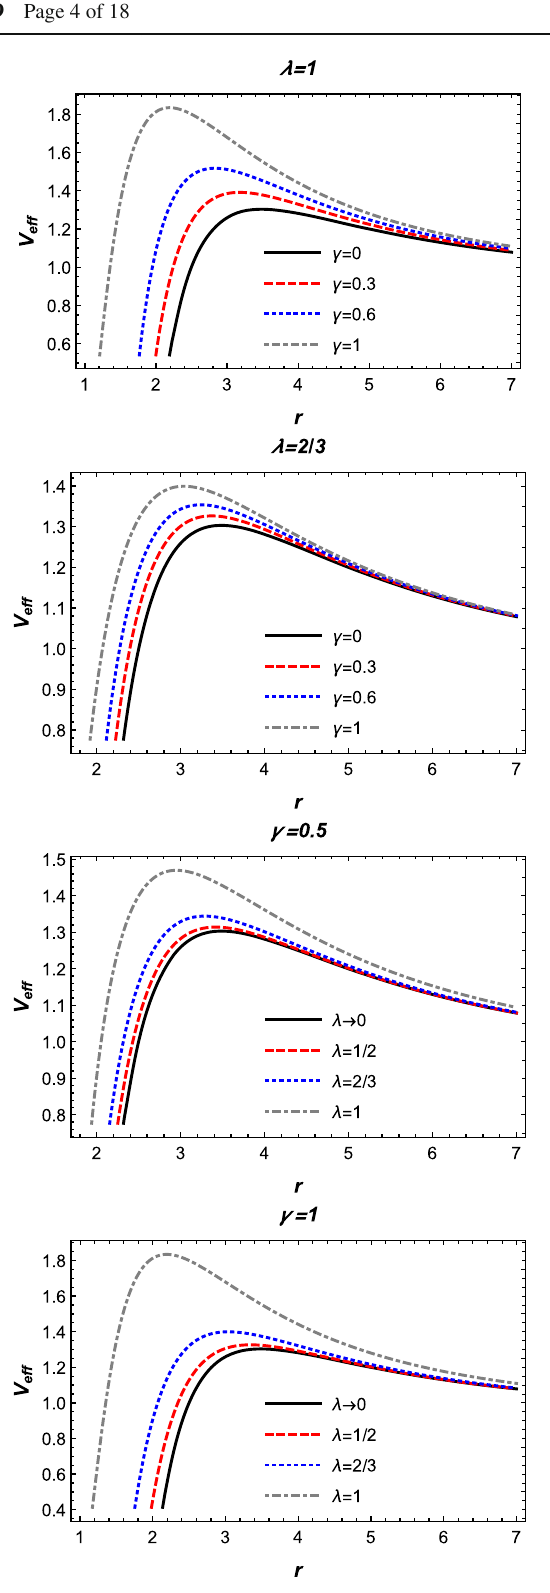
Fig. 2 The dependence of effective potential V ef f on radial coordi- nates for different values of λ and γ for the massive particle